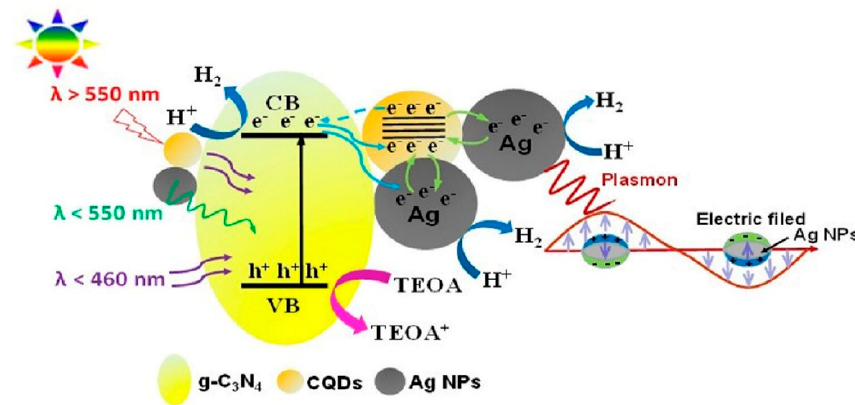
Figure 16. Schematic illustration of the charge generation and transfer procedure of the Ag/CQDs/g- C 3 N 4 composite combined with a conjectural photocatalytic H 2 evolution mechanism (reproduced with permission from [89]. Copyright Elsevier, 2017).